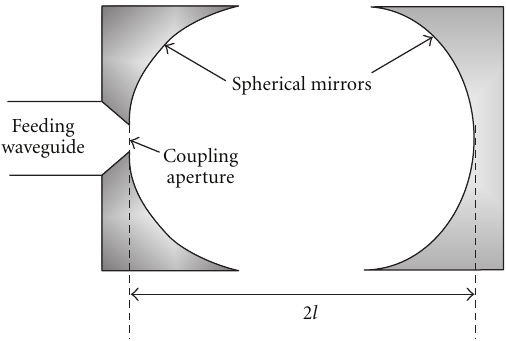
Figure 1: Open cavity fed by a rectangular waveguide.